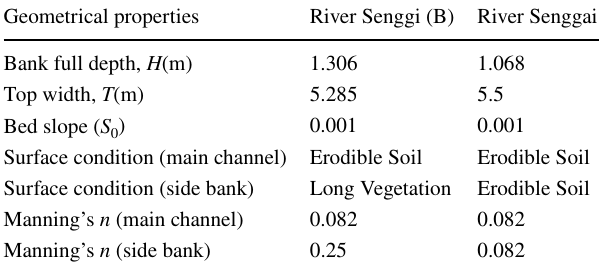
Table 3 Geometric properties and surface conditions used for natural river data